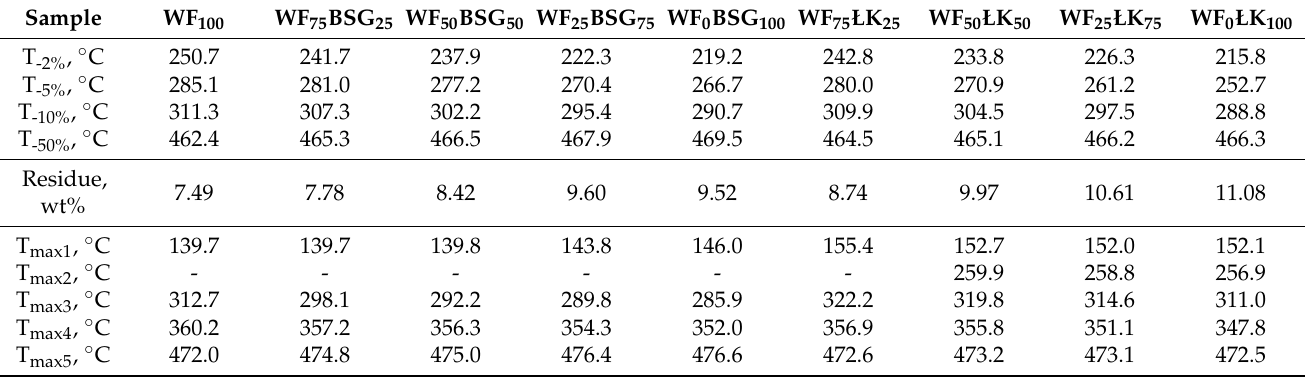
Table 5. The results of thermogravimetric analysis of prepared